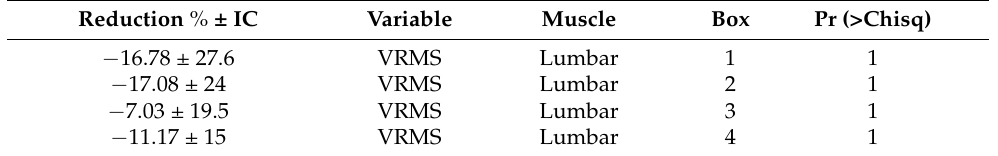
Table A2. The first column includes the percentile of reduction with the confidence interval. The second column shows the variable, in this case, the VRMS; the third column, the muscle; and the fourth column, the number of box. Last value contains the p -value of the